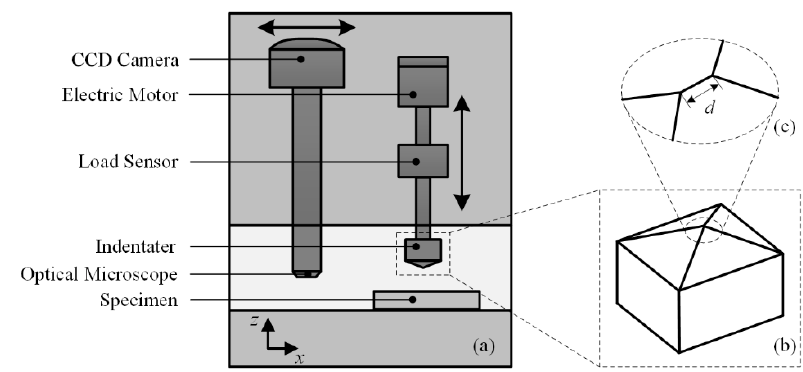
Figure 1. Schematic diagram of a micro-hardness system. CCD—charge coupled device.